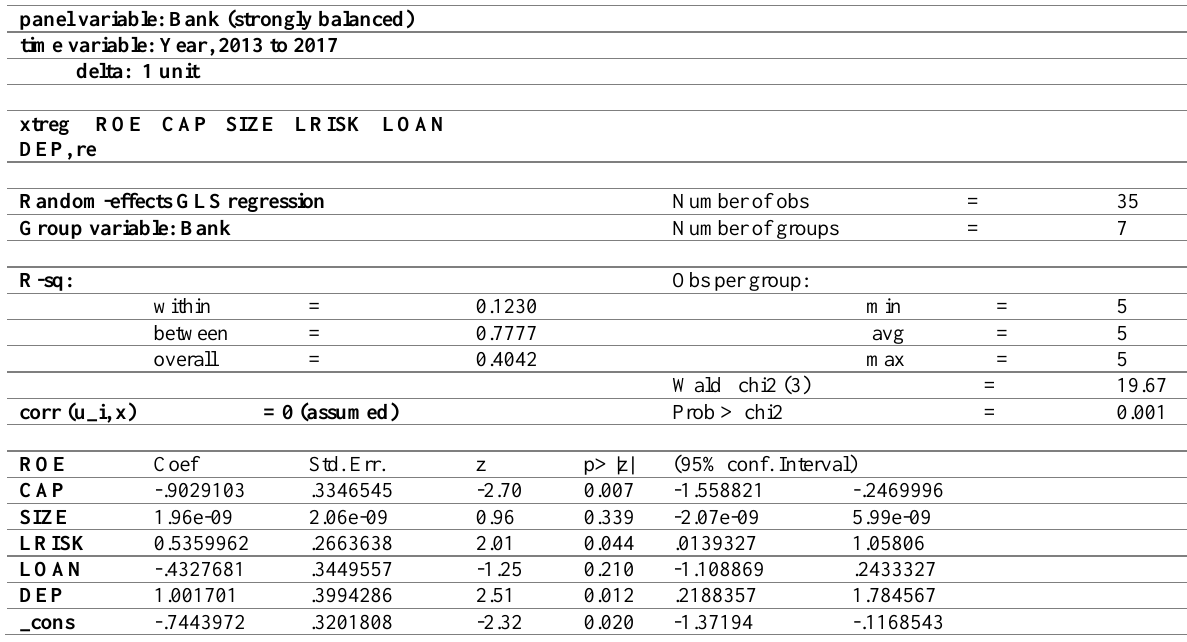
Table 5: Analysis on the Influence of Bank-Specific Factors on